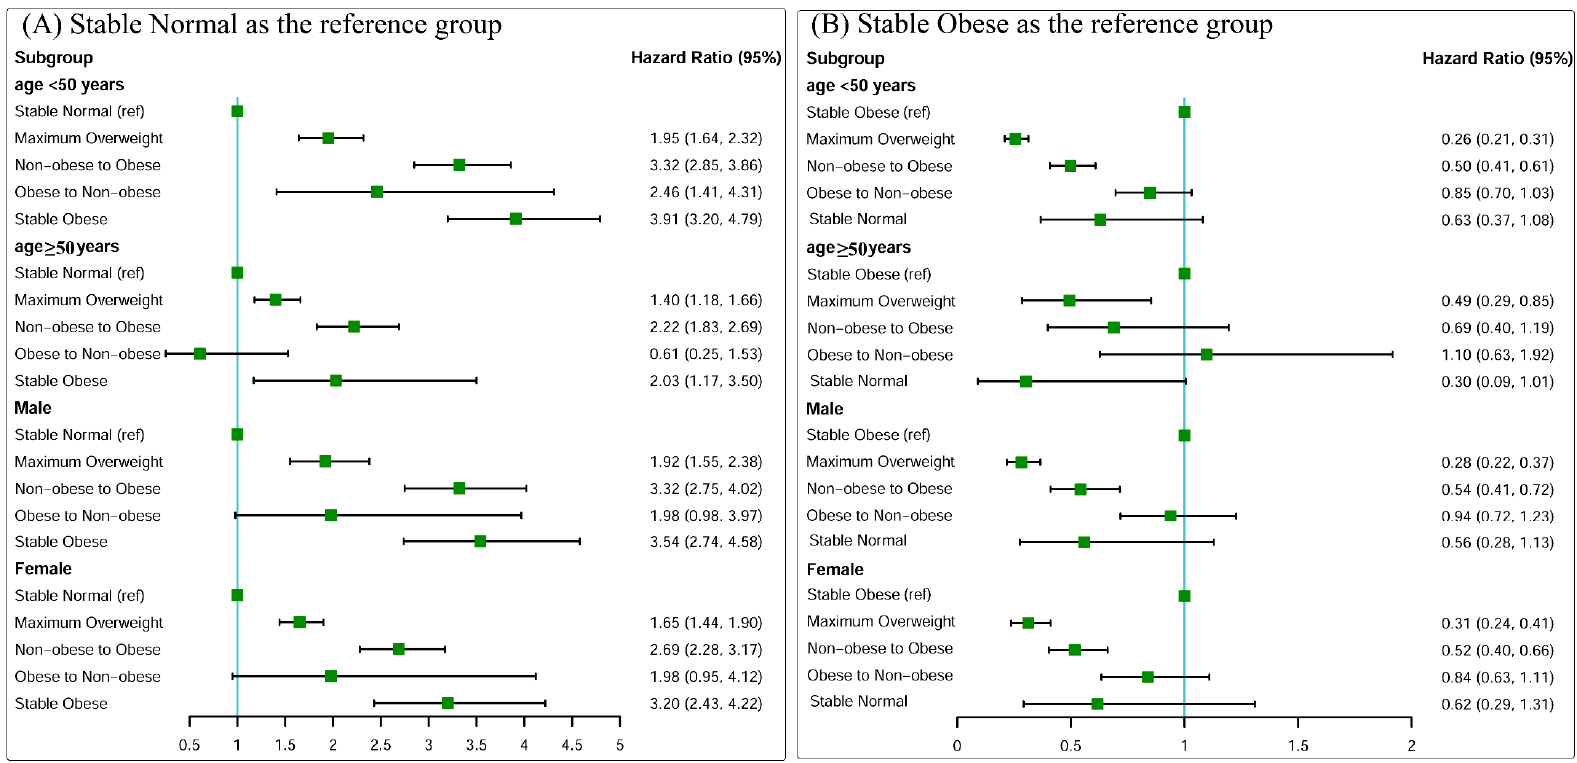
Figure 3. Associations between weight change patterns across adulthood and risk of incident hypertension stratified by baseline age, sex. ( A ) Stable normal as the reference group; ( B ) stable obese as the reference group. Risk estimates were adjusted for sex (not adjusted in stratified analysis by sex), baseline age (not adjusted in stratified analysis by age), race/ethnicity, family income, education, and smoking status.